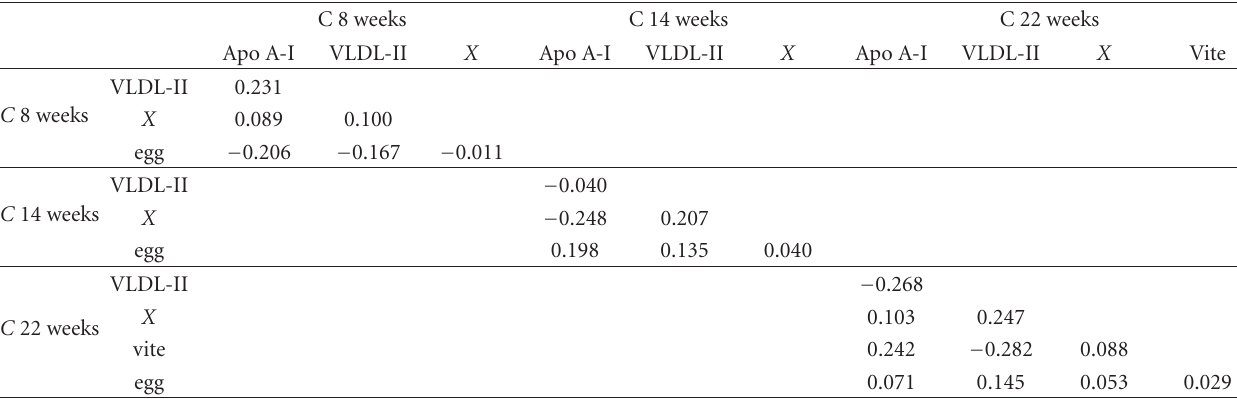
Table 7: The Pearson’s correlation coe ffi cient of C dataset is between serum protein concentrations apolipoprotein A-I, apo VLDL-II, X protein and Vitellogenin.